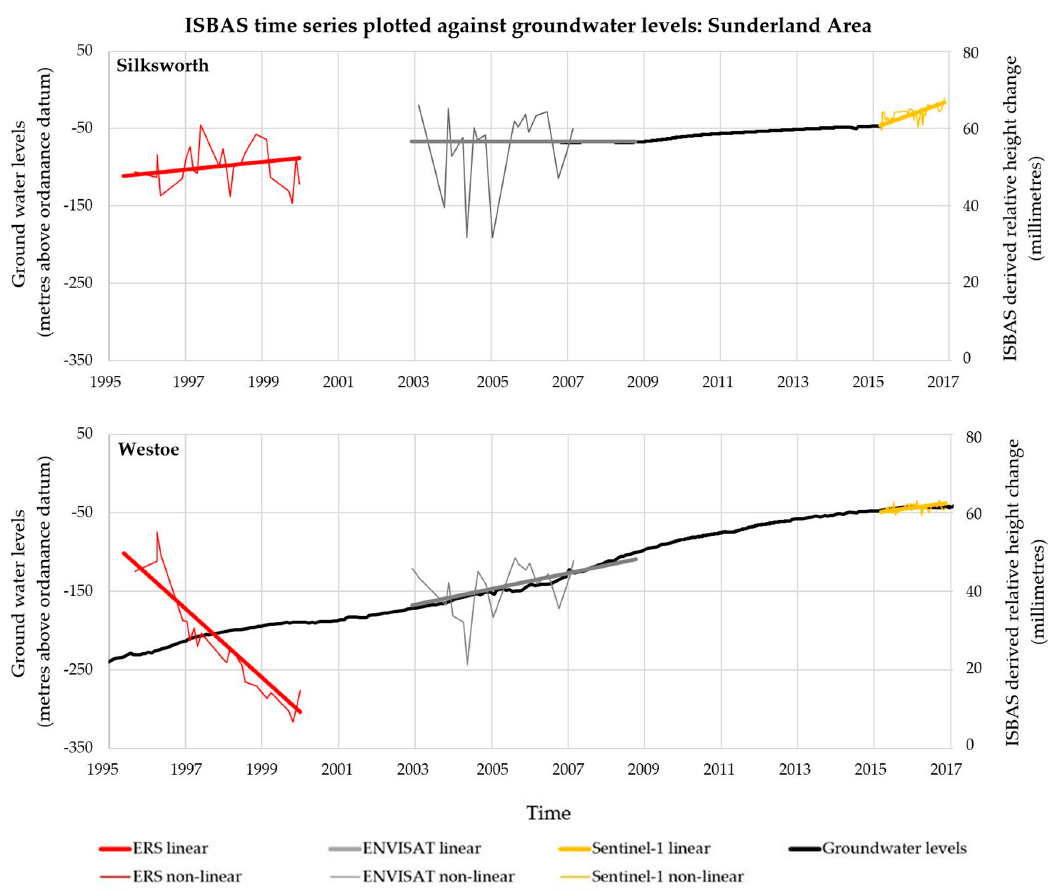
Figure 9. Groundwater levels plotted against neighbouring ISBAS time-series and linear velocities (derived separately) at Silksworth and Westoe, the locations of which are marked on Figure 8.